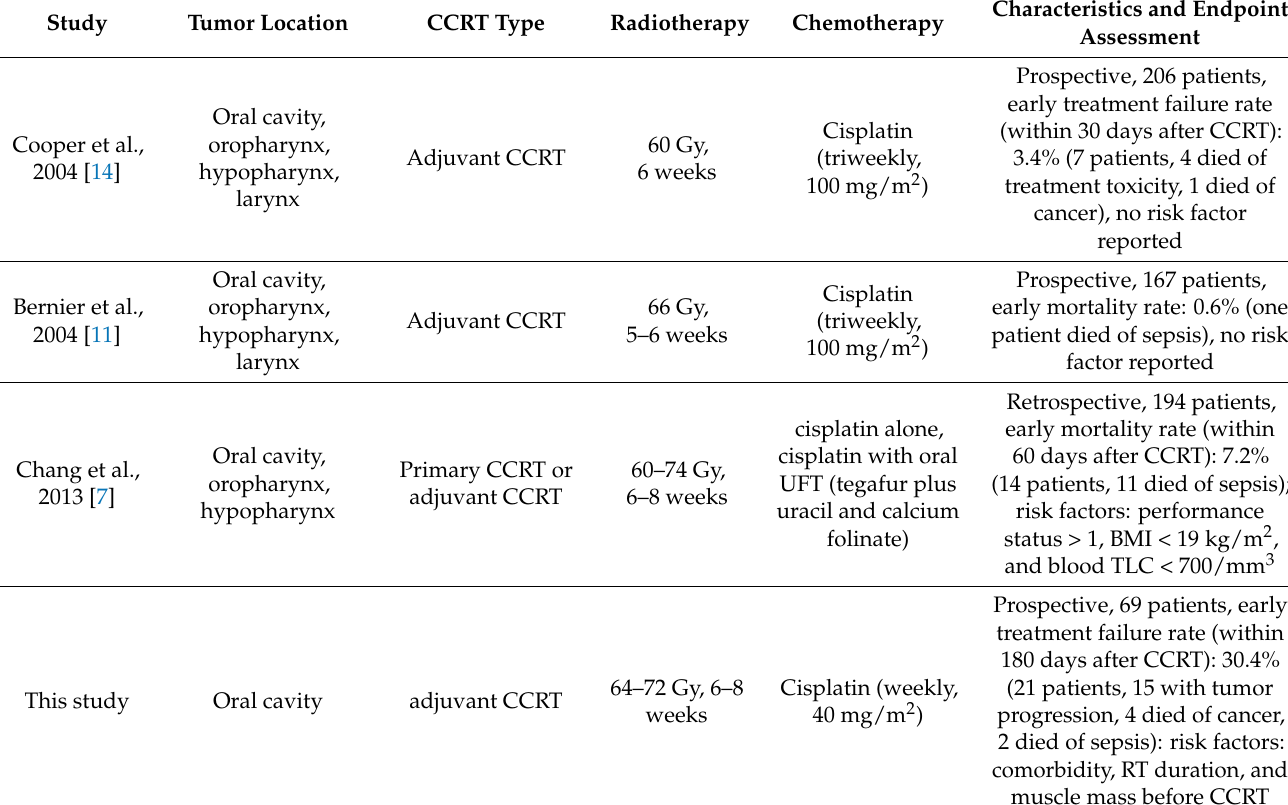
Table 5. Studies reporting early treatment failure in oral cavity cancer patients treated with adjuvant